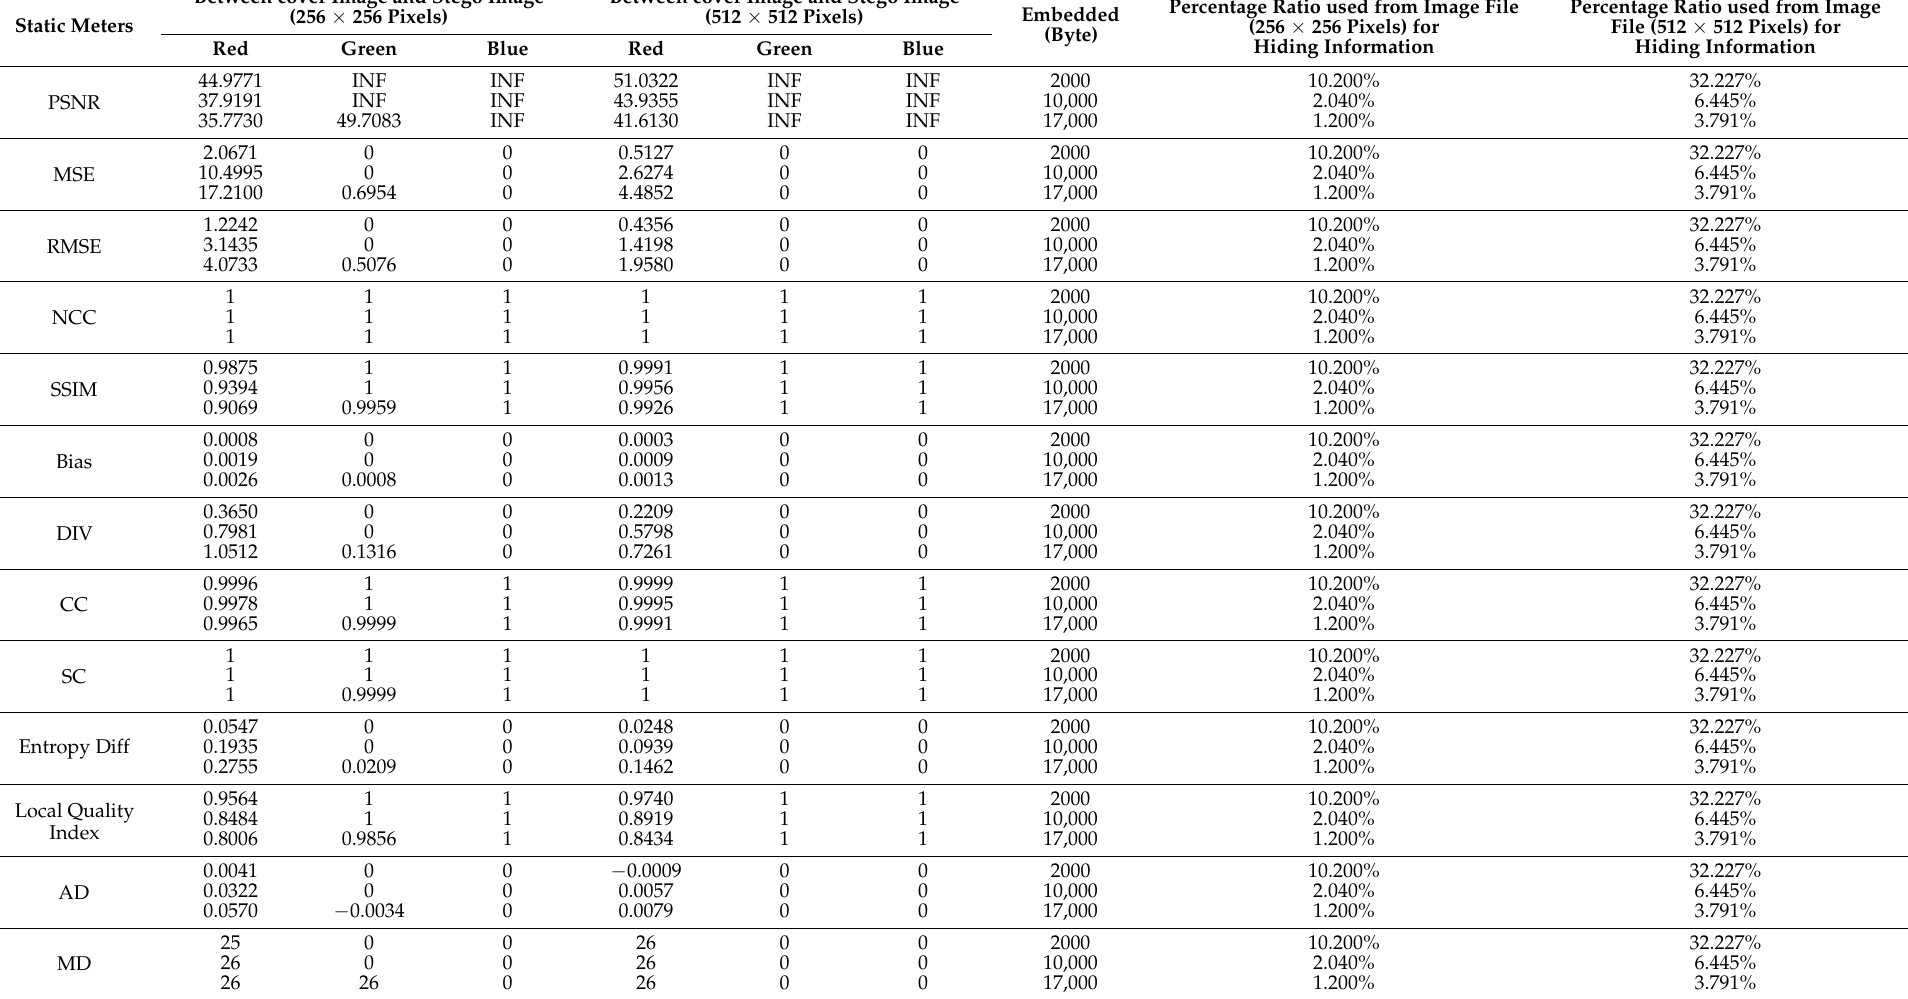
Table 1. Performance of PSNR, MSE, SSIM, NCC, and embedding capacity in Lina images of different